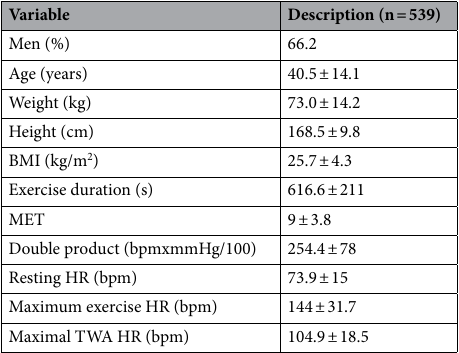
Table 1. General characteristics of the studied sample. Values expressed in percentages (%) for male distribution, and mean followed by standard deviation for the other variables BMI Body Mass Index, HR Heart Rate, MET Metabolic Equivalent of the Task (MET = VO2máx/3,5 − 1 MET = 1 kcal/kg/h).